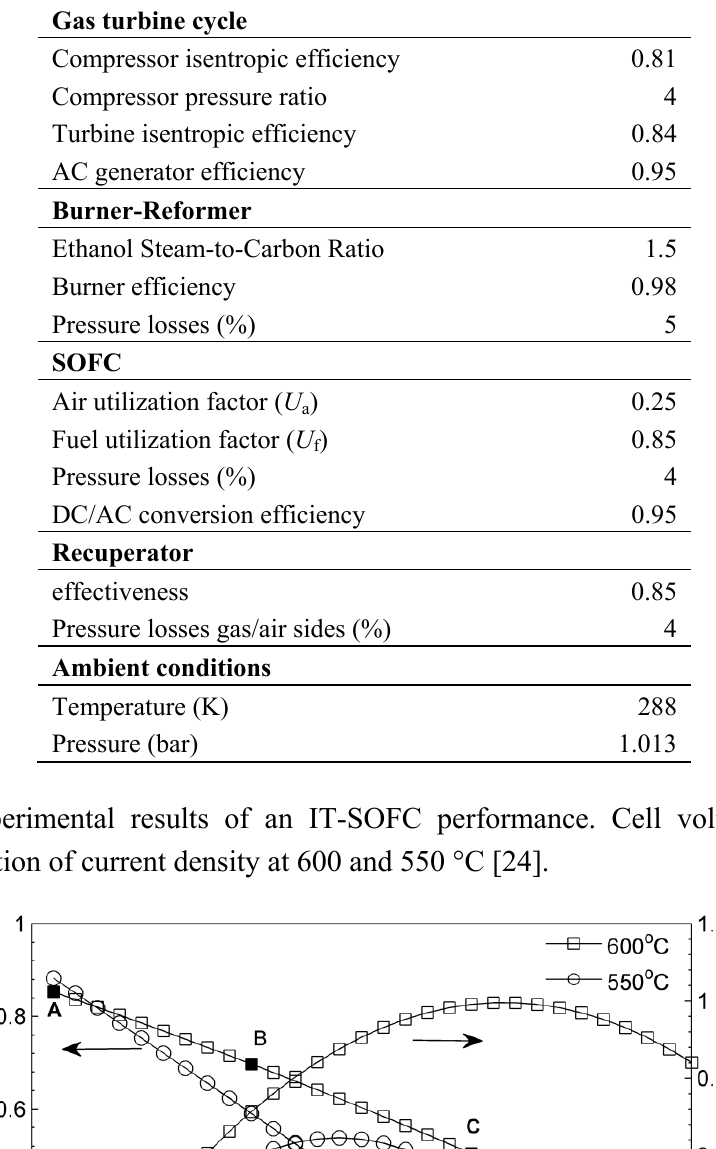
Table 1. Main operating parameters of the SOFC-GT system [13,17].